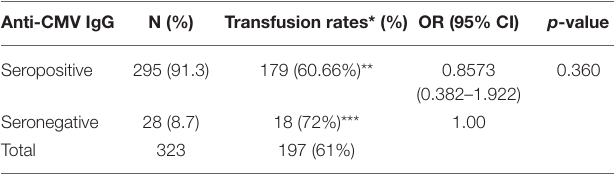
TABLE 2 | Prevalence rates of CMV infection according to the type of hematological disease. Hematological